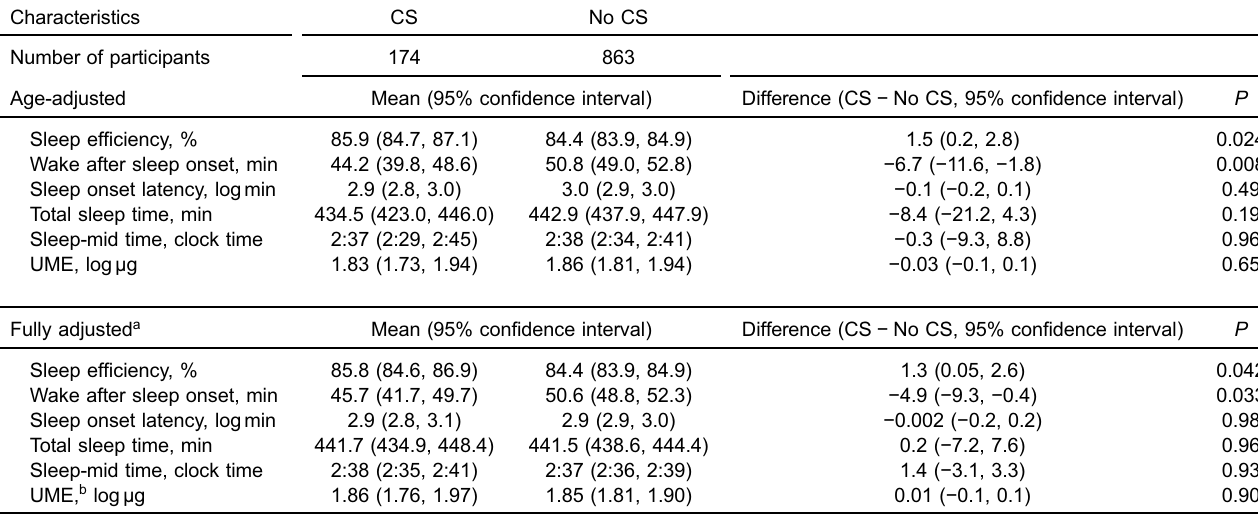
Table 2. Comparisons of objective sleep parameters by CS status using analysis of covariance Characteristics